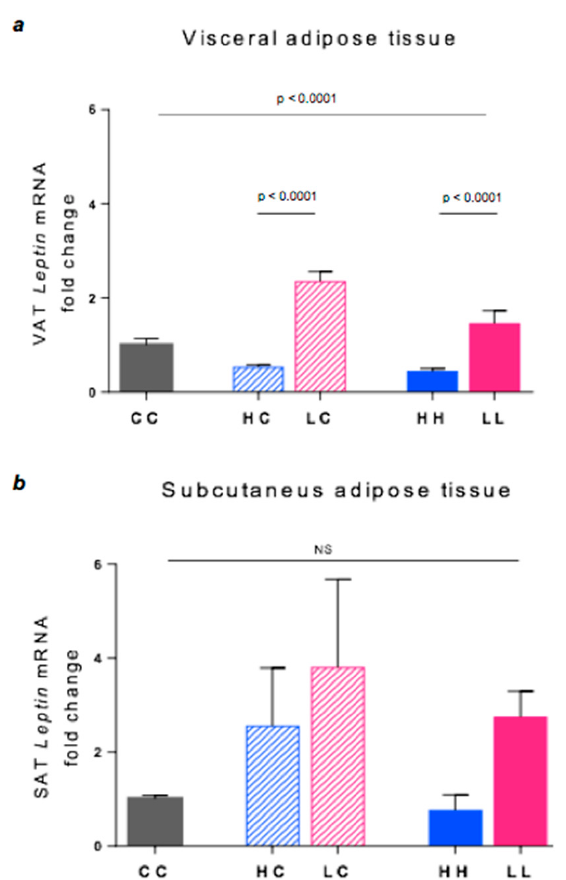
Figure 5. Leptin gene expression in the ( a) VAT and ( b ) SAT. Data represent the Mean ± SEM. ( a ) CC n = 5, HC n = 6, LC n = 6, HH n = 6, LL n = 6. ( b ) CC n = 6, HC n = 7, LC n = 7, HH n = 4, LL n = 4. NS = not significant.